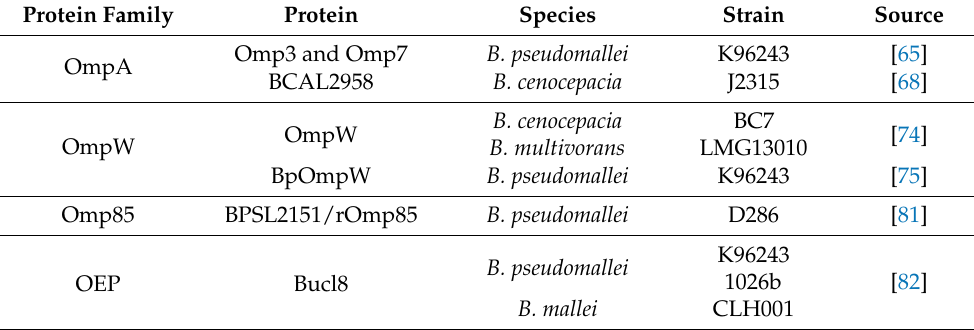
Table 1. Vaccination